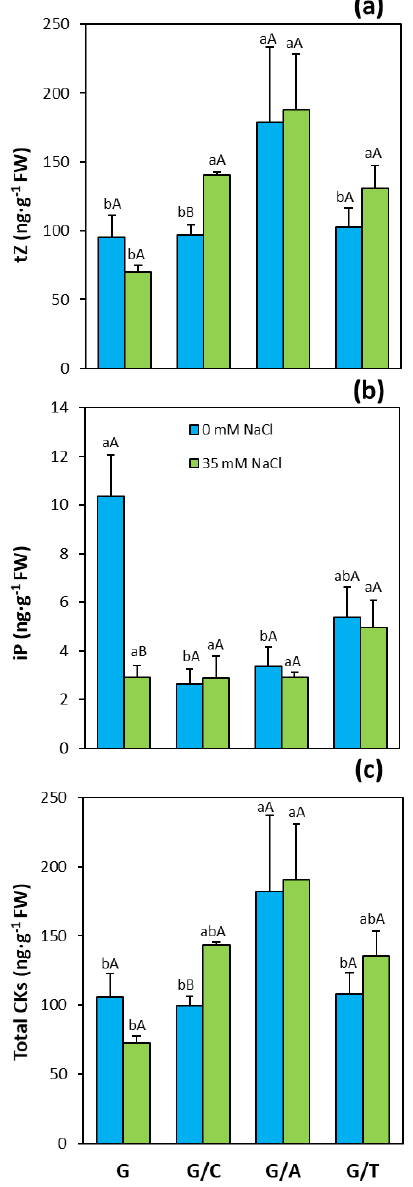
Figure 4. ( a ) Trans -zeatin (tZ), ( b ) isopentenyladenine (iP), and ( c ) total cytokinin (CKs) concentrations in leaves of pepper plants of the commercial variety “Gacela F1” either non-grafted (G) or grafted onto the commercial rootstocks Creonte (G/C), Atlante (G/A), and Terrano (T/A), and cultivated under control (0 mM NaCl) and salinity (35 mM NaCl) conditions. Bars show the means of five plants ± standard error. Different capital letters indicate significant differences due to the salt treatment while different small letters show significant differences among graft combinations according to Tukey’s test ( p ≤ 0.05).